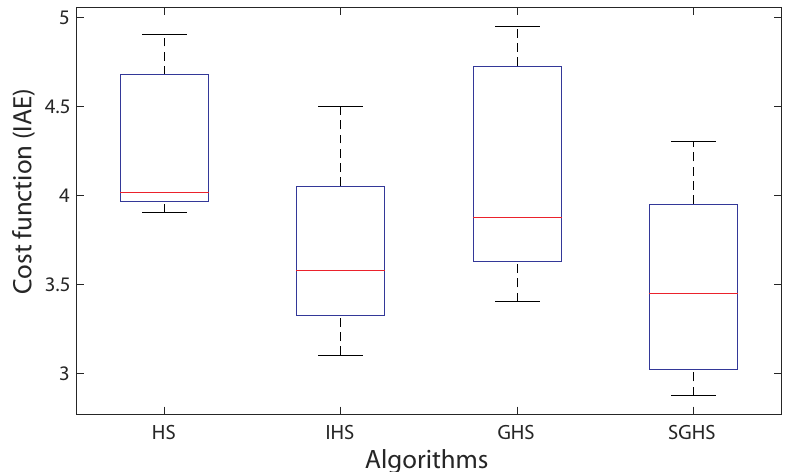
Figure 11. Box-and-whisker plot of the optimization results using HS, IHS, GHS and SGHS algorithms.